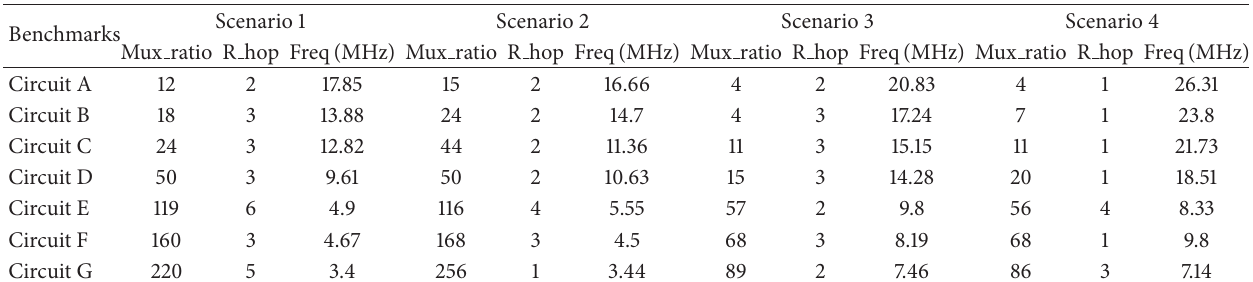
Figure 12: Prototyping board based on six Virtex-VI from Dini group [17]. Table 2: Comparison of routing strategies effects on prototyping system